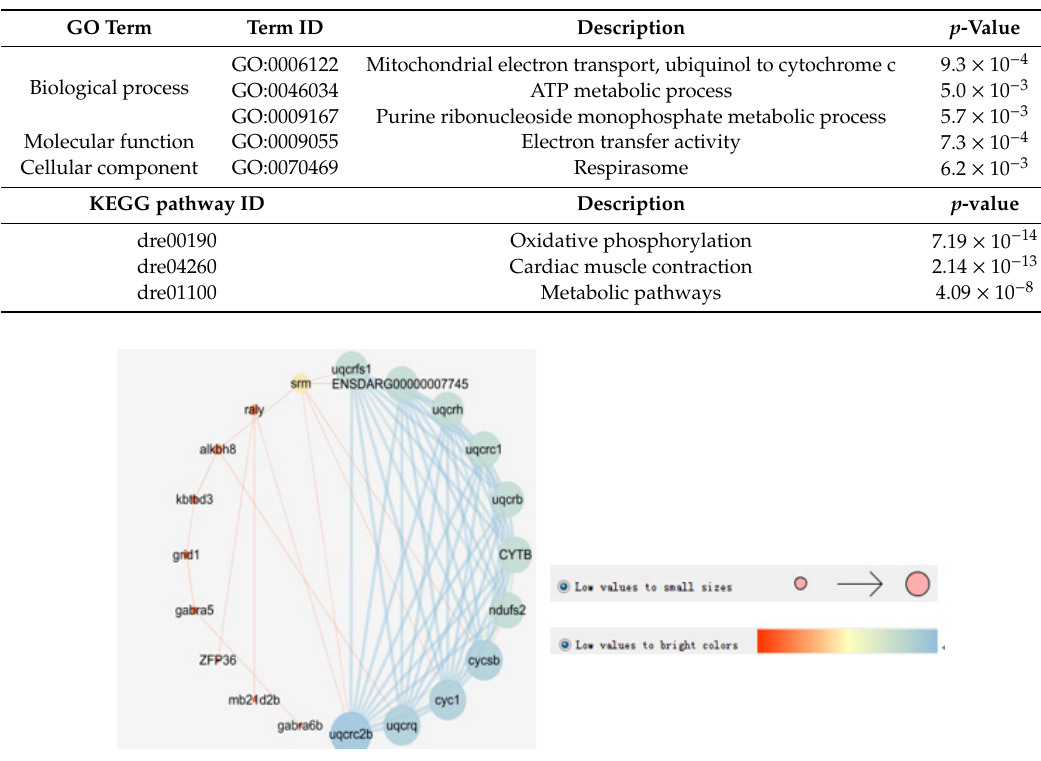
Table 4. Enriched GO and Kyoto Encyclopedia of Genes and Genomes (KEGG) pathway analyses in the STRING protein network.